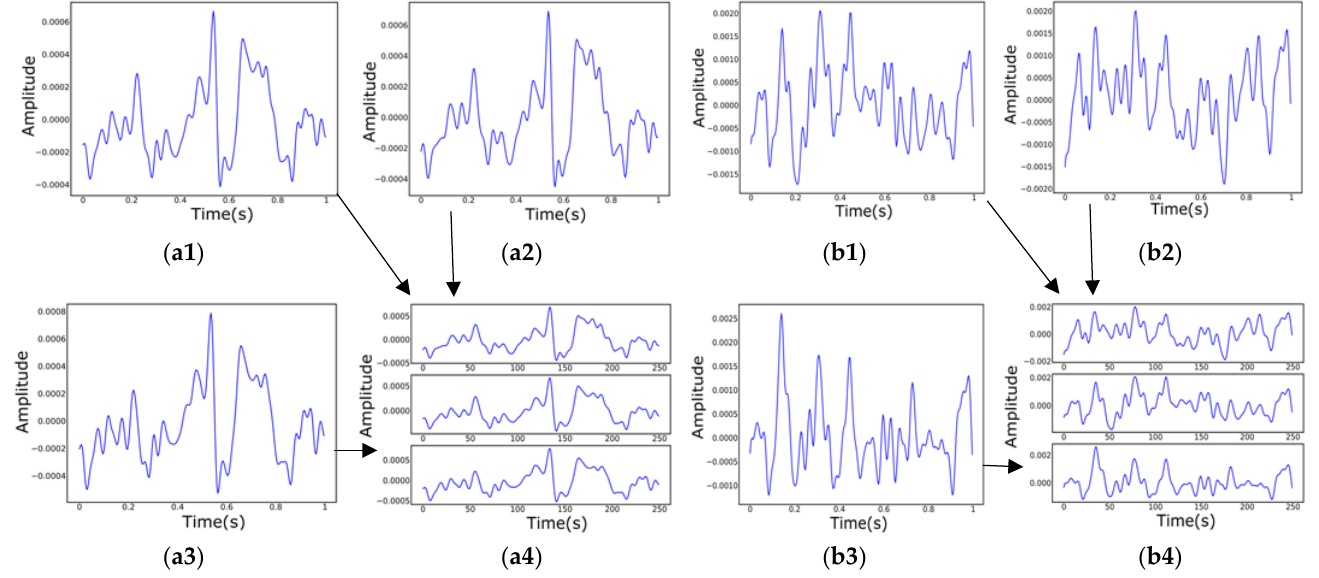
Figure 3. Draw Fp1, Fpz, and Fp2 on the same picture in the sequence. ( a1 – a4 ) The three channels of data for depression sample (subject ID: 02010003) are plotted separately; ( a1 ) Fpz; ( a2 ) Fp1; ( a3 ) Fp2; ( a4 ) Three diagramming; ( b1 – b4 ) The three channels of data for health sample (subject ID: 02020004) are plotted separately.